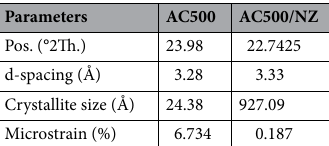
Table 1. The XRD data for the plane (002) in AC500 and AC500/NZ samples.